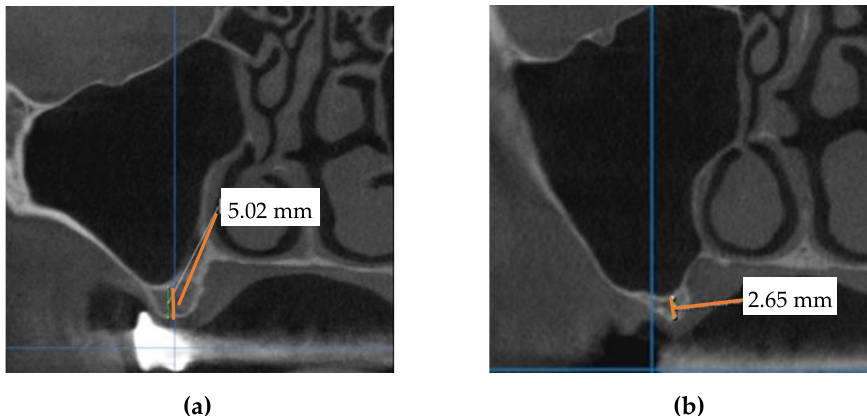
Figure 2. Cross sectional CBCT views corresponding to: (a) the 16 with a bone height of 5.02 mm; Figure 2. Cross-sectional CBCT views corresponding to: ( a ) the 16 with a bone height of 5.02 mm; ( b ) the 17 with a bone height of 2.65 mm and insufficient crestal width.